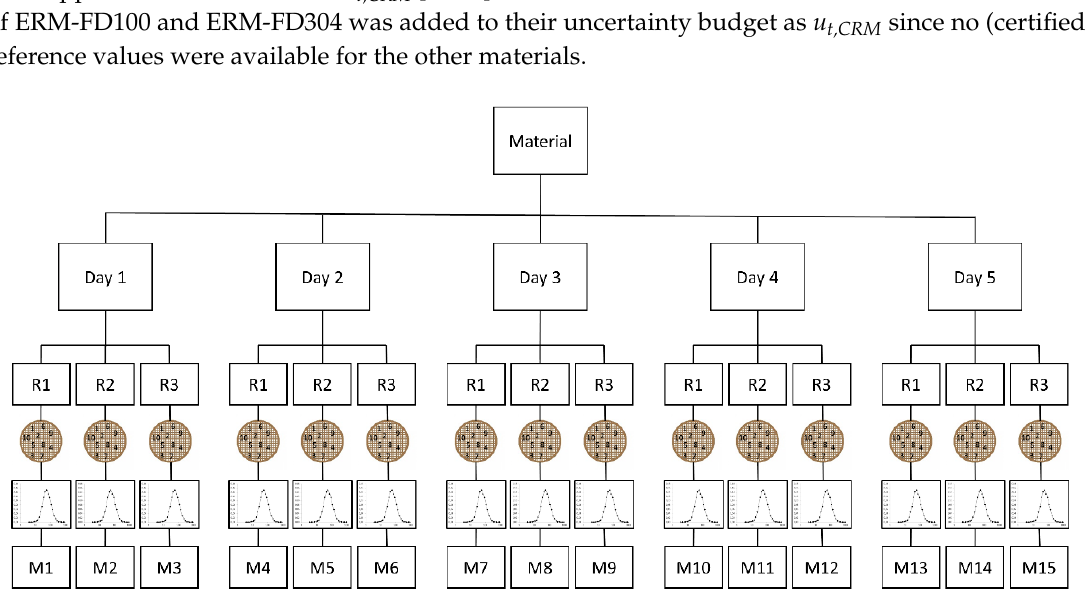
Figure 2. Schematic representation of the experimental design of the intra-laboratory validation study, with R = repetition and M = measurement.